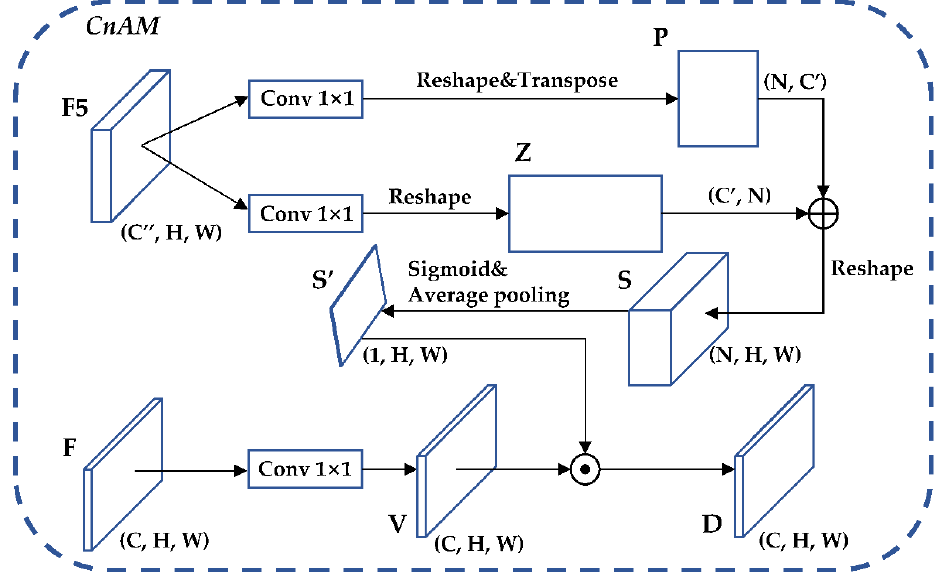
Figure 10. CnAM structure diagram.